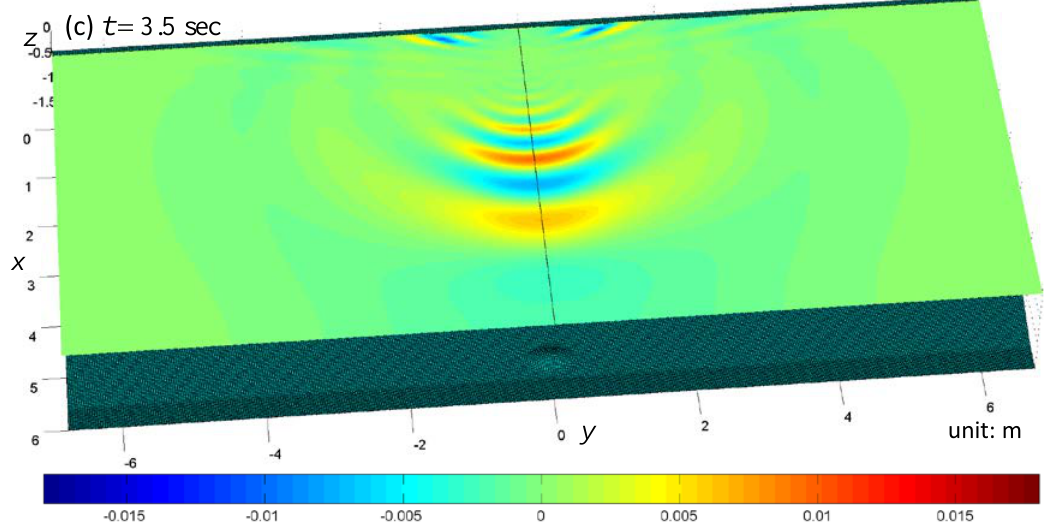
Figure 14. Snapshots of the free surface elevation in case 2 in a wider wave flume. ( a ): t = 0.5 sec; ( b ): t = 2.0 sec; ( c ): t = 3.5 sec.